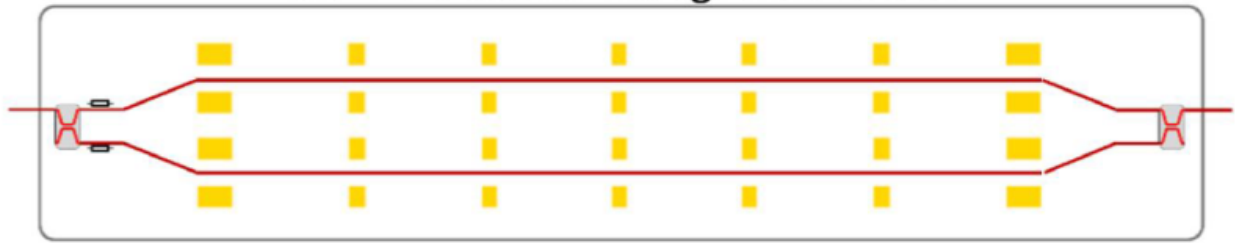
Figure 20. Parallel architecture proposed in [57]. The basic goal of a parallel design is to generate optical multilevel PAM signals using only binary driving digital signals. As shown in Figure 20, 1-bit intensity or phase gates are the fundamental building blocks that are required at each one of the oDAC paths. These gates are practically implemented using MZMs that are properly biased and driven by electrical signals [57]. Then, by adding all the optical paths via a variable combiner, one can produce optical signals with different amplitude/phase values (and thus multi-level m-PAM/m-QAM). Moreover, extensive analysis has been performed in [57] to demon- strate the significance of variable, controllable splitting and combine ratios to realize such a design in an operationally efficient way. To be able to achieve proper operation under dynamically changing operational conditions, the authors added control and calibration functionalities to their architecture along the optical paths by utilizing slow phase-modu- lators. With this type of treatment of the possible mismatches in splitting or combine ratios